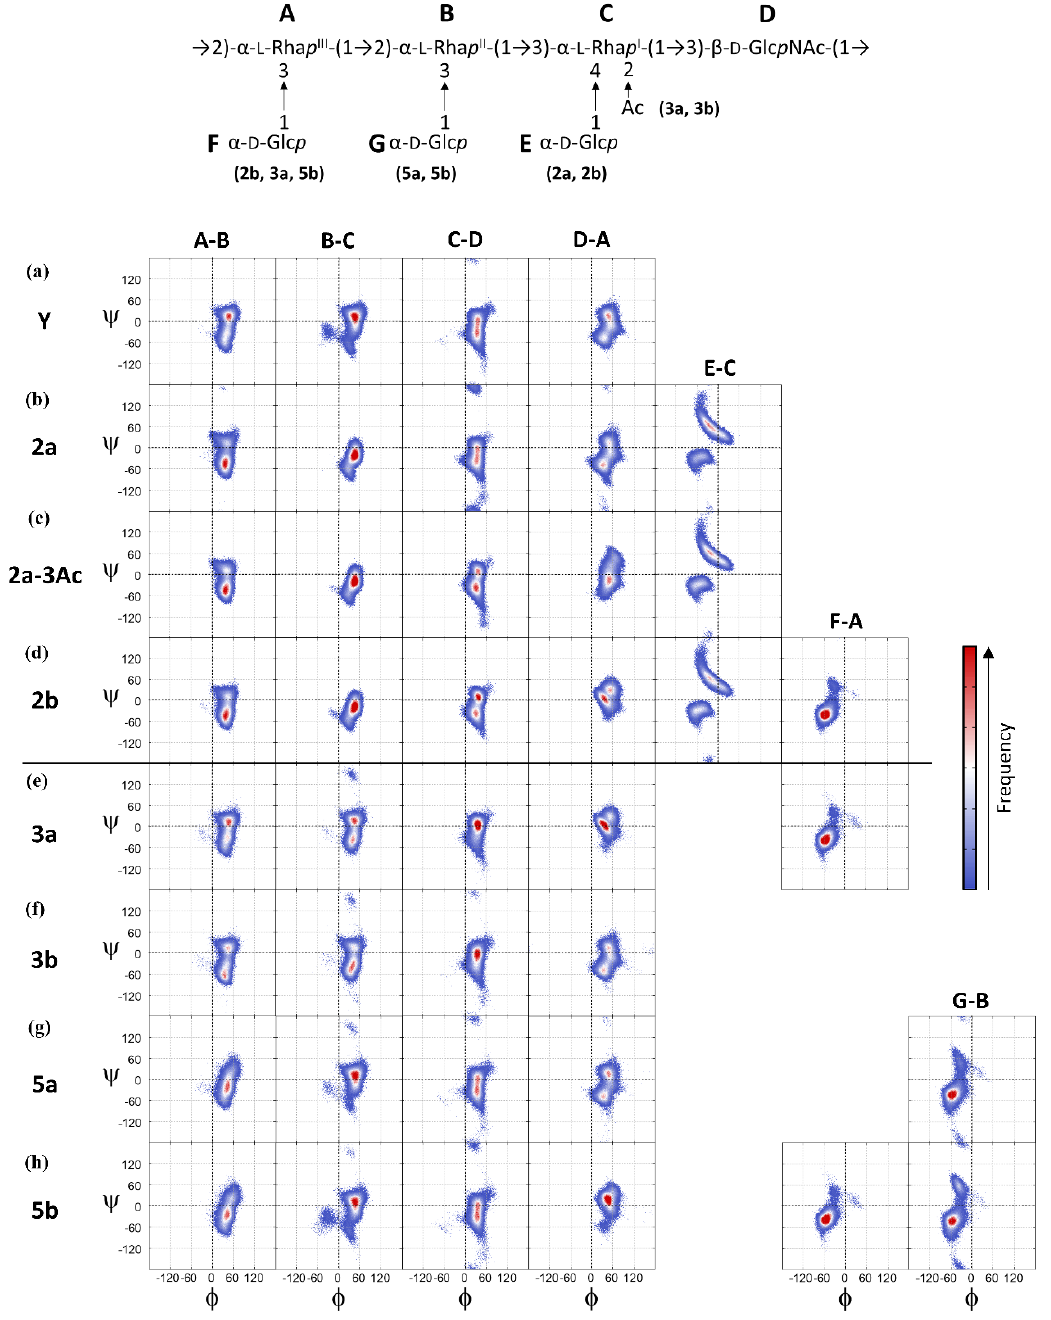
Figure 4. Heat map representations of scatter plots for the ϕ , ψ dihedrals of each glycosidic linkage for serotypes ( a ) Y, ( b ) 2a, ( c ) 2a-3Ac, ( d ) compared to serotypes ( e ) 3a, ( f ) 3b, ( g ) 5a, and ( h ) 5b in this study. The heat maps combine the points from both central repeating units (RU 3 and RU 4) to broadly sample backbone behavior. The color scale to the right indicates the relative occupancy of the dihedral angles during the simulations.